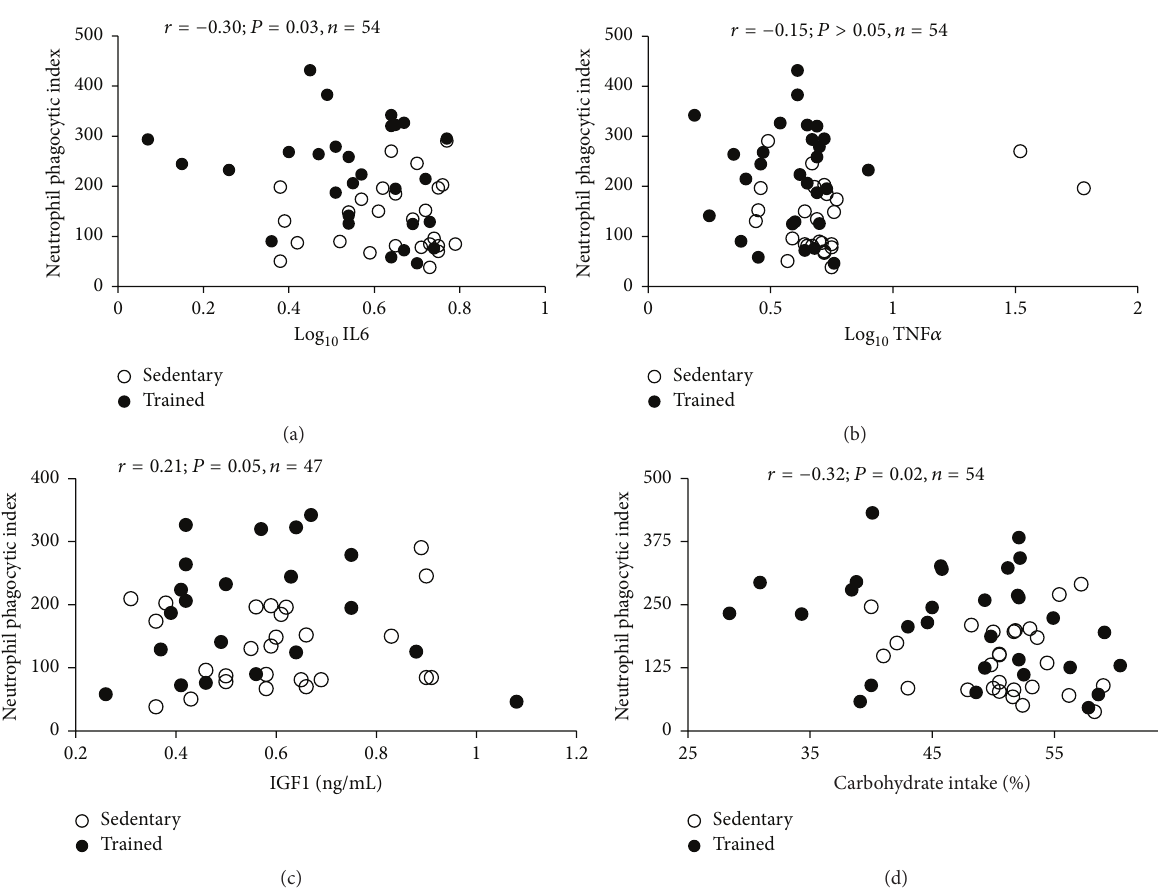
Figure 2: Correlations of log 10 IL6 (a), log 10 TNF 𝛼 (b), IGF1 (c), and total carbohydrate intake (d) with neutrophil phagocytic index. 𝑟 = Pearson’s correlation